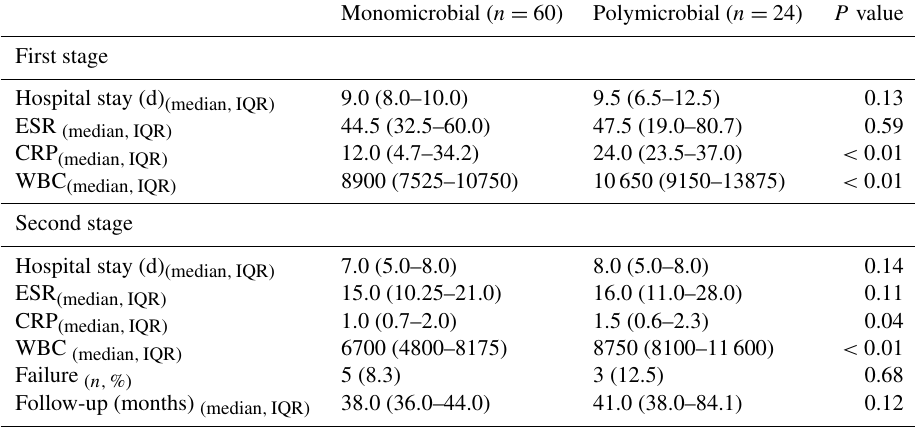
Table 3. Postoperative data summary of patients with monomicrobial and polymicrobial hip PJI. Monomicrobial ( n = 60)